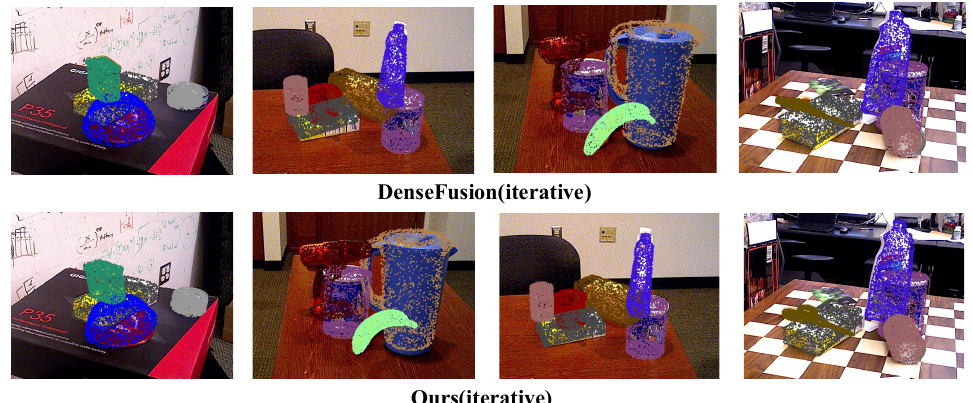
Figure 13. In order to obtain a more intuitive comparison, some qualitative results are shown here. All results are predicted based on the same segmentation mask as PoseCNN. The dots of different colors represent objects of different categories. The name below the image indicates the name of the